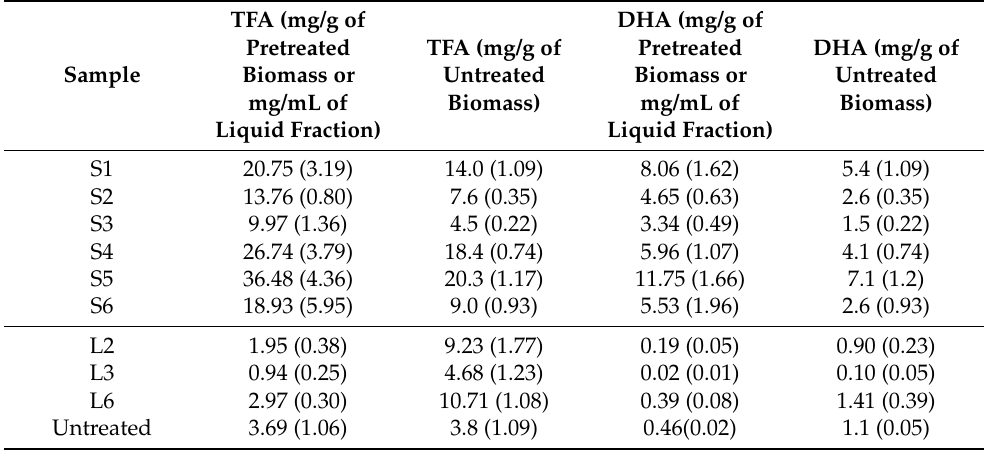
Table 5. Summary of total TFA and DHA yields per g of pretreated solid pulp or mL of aqueous liquid fraction and overall yields per g of untreated biomass. Standard errors are given in